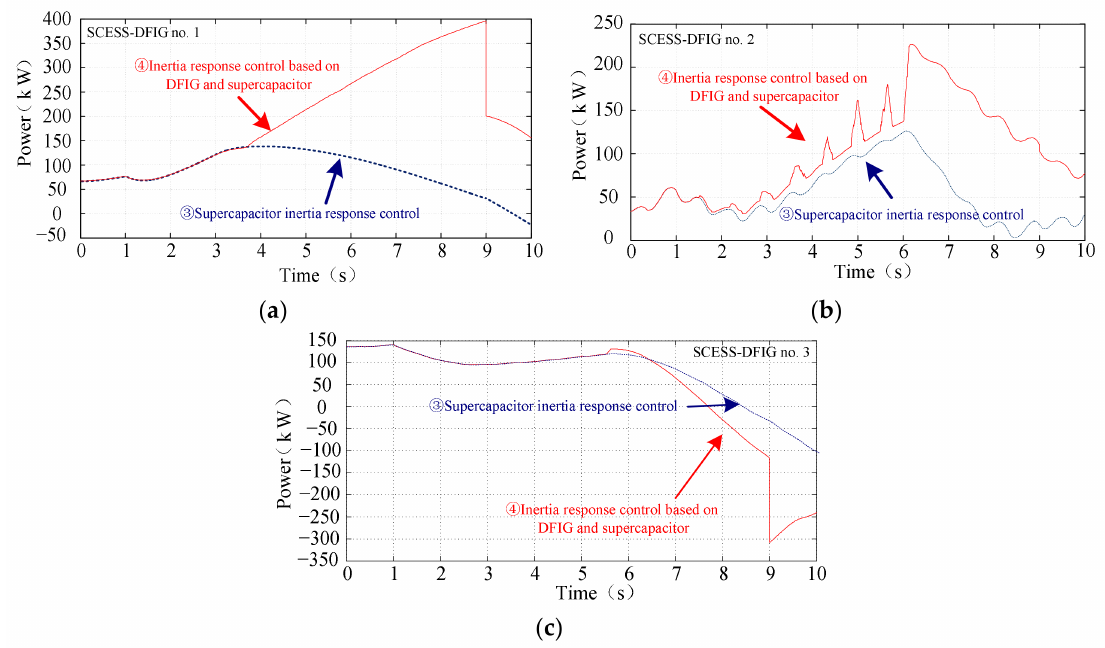
Figure 18. Comparison of output power of the single RSC under different control strategies: ( a ) The RSC output power under different control strategies for no. 1 SCESS-DFIG; ( b ) The RSC output power under different control strategies for no. 2 SCESS-DFIG; ( c ) The RSC output power under different control strategies for no. 3